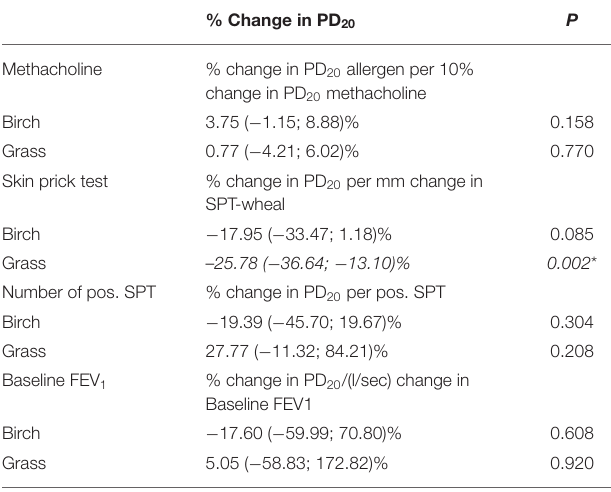
TABLE 2 | The associations between the baseline characteristics for the two participants groups (birch and grass), and Allergen-PD 20, Methacholine-PD 20 , size of SPT, number of positive SPT, and baseline forced expired volume in the first second (FEV 1 ). % Change in PD